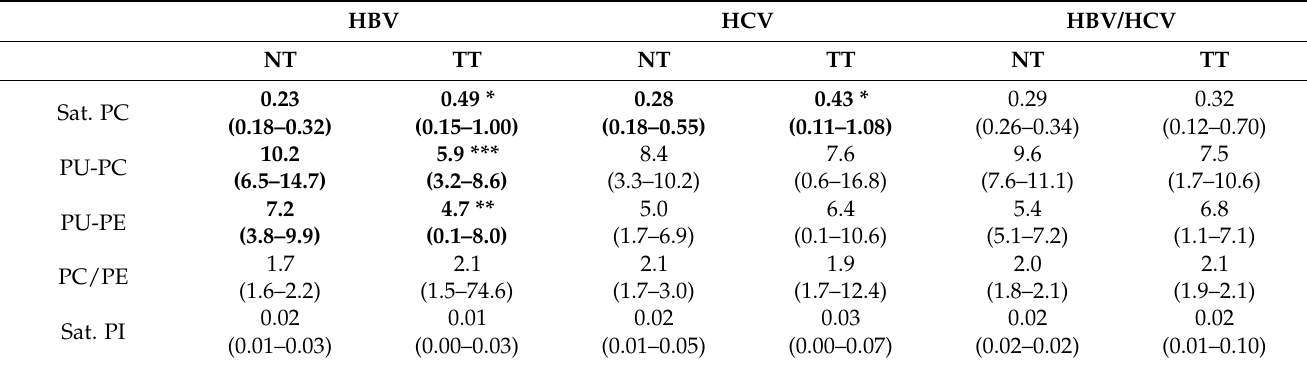
Figure 3. Phospholipid, diacylglycerol and free cholesterol levels in non-tumor liver tissues of patients with HBV, HCV and HBV/HCV infection. ( A ) Phosphatidylcholine (PC), phosphatidylethanolamine (PE), phosphatidylserine (PS), lysophosphatidylcholine (LPC) and phosphatidylinositol (PI) levels in the liver of HBV, HCV and double infected patients; ( B ) Polyunsaturated (PU) phospholipids; ( C ) PC/PE ratio; ( D ) free cholesterol (FC), PU-diacylglycerol (DG) and PU-phospholipids in patients with increasing fibrosis stages; ( E ) FC, PU-DG and PU-phospholipids in patients with fibrosis scores 0/1/2 and fibrosis scores 3/4; ( F ) PC/PE ratio in patients with fibrosis scores 0/1/2 and 3/4. * p < 0.05, ** p < 0.01 for comparison of HBV and HCV. (One-way ANOVA). Table 1. Phospholipids in non-tumor (NT) and tumor tissues (TT) of the 10 HBV, 11 HCV and 3 double-infected patients. Levels of saturated PE and PS were below 0.001 nmol/mg and are not included. Lipid concentrations (nmol/mg) are given as median values and range. Phosphatidylcholine, PC; phosphatidylethanolamine, PE; phosphatidylinositol, PI; phosphatidylserine, PS; polyunsaturated, PU; saturated, sat. * p < 0.05 and ** p < 0.01 and *** p < 0.001 compared to the respective NT using a paired Students’ t -test. Significantly different lipid levels in NT and TT are in